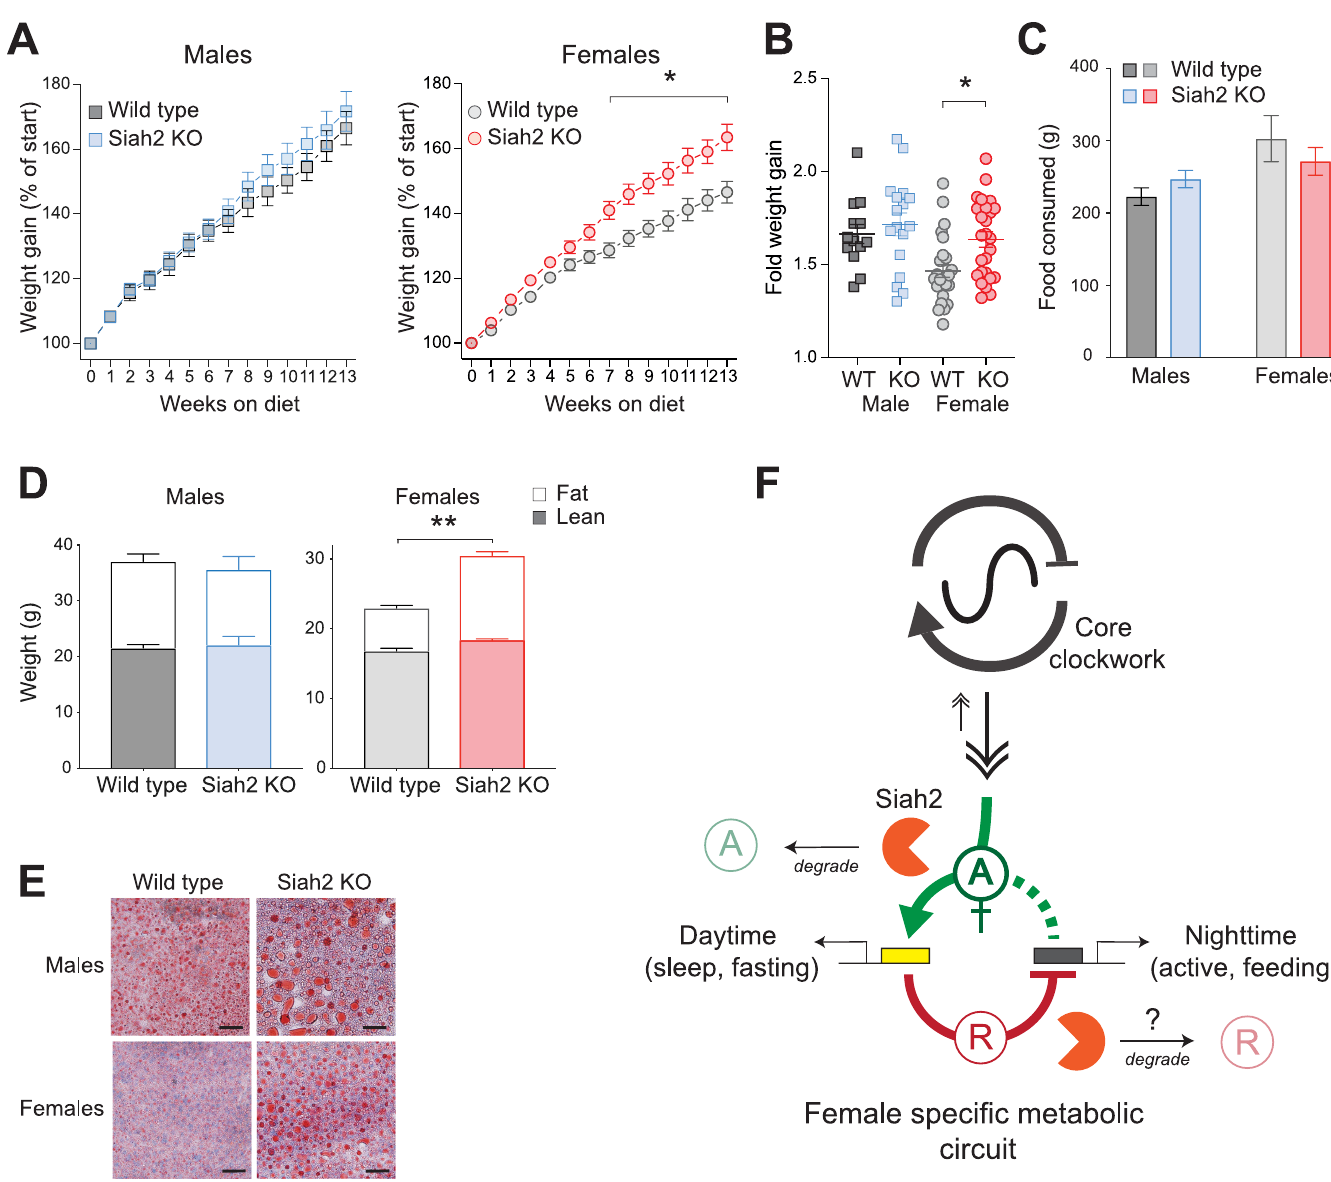
Fig 6. SIAH2 protects females from diet-induced metabolic disorders. ( A ) Weight gain in mice fed high fat diet (45% fat). n = 13–17 male mice, combined from two trials, or 26–27 female mice from 4 trials. Two-way ANOVA indicated a significant interaction between genotype x time on diet in females only (p < 0.0001, F (13, 663) = 6.484), with significant differences in weight gain by week 7 ( � = p < 0.01, Sidak’s multiple comparison test). ( B ) Fold weight gained at 13 weeks for the mice in A ( � p < 0.0001, t = 4.809, df = 714). ( C ) Consumption of HFD over the experiment; no statistical differences between any groups. ( D ) Loss of SIAH2 significantly increased adiposity in females on HFD for 13 weeks ( �� p = 0.0044, t = 4.13, DF = 15). ( E ) Oil Red O staining of liver from mice fed HFD for > 13 weeks. Red staining = fat. Scale bar = 50 microns. ( F ) Model depicting how SIAH2 may regulate rhythmic gene expression in females. Our data suggest SIAH2 may, in a female-specific manner, regulate one or more transcriptional activators (green) and/or repressors (red), perhaps connected in a circuit or loop (dashed green line) that normally links the circadian clockwork to metabolic control in